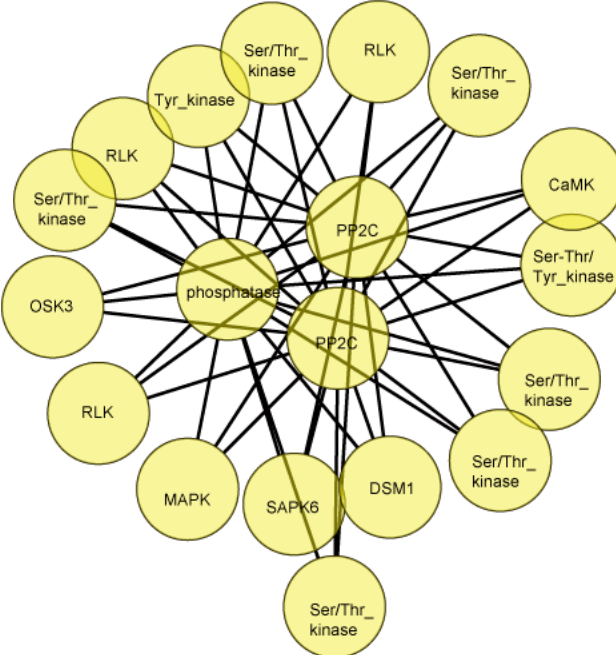
Figure 7. A network analysis of the set of differentially phosphorylated kinases and phosphatases. The full form of the abbreviated ID’s is given in Table S6.